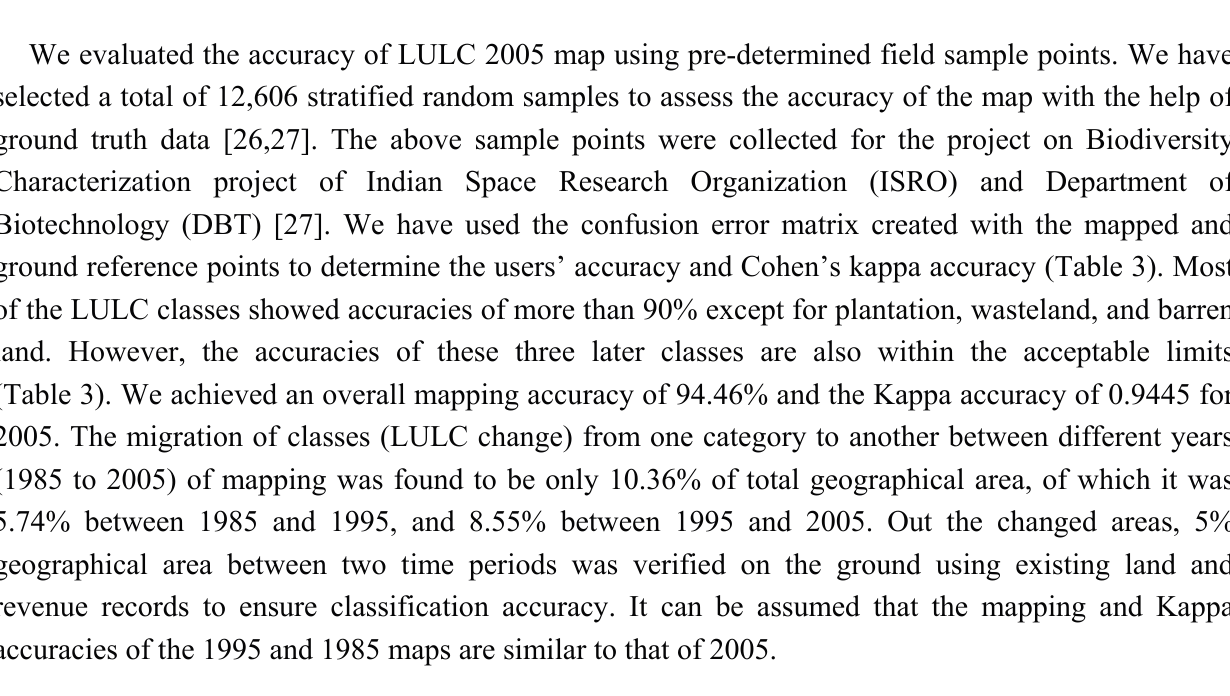
Table 3. Land use/land cover (LULC) classification scheme and description of